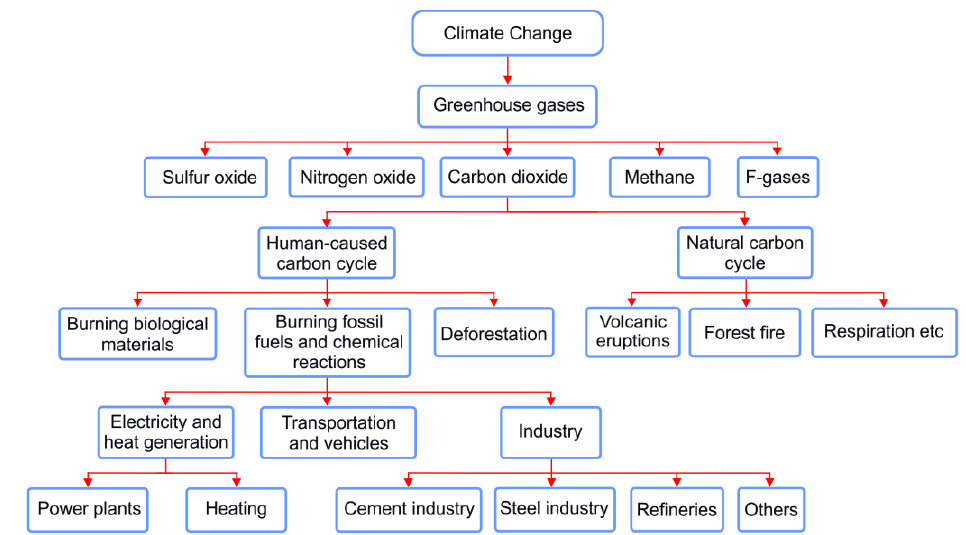
Figure 2. Overview of the main roots of human-related CO 2 emissions.